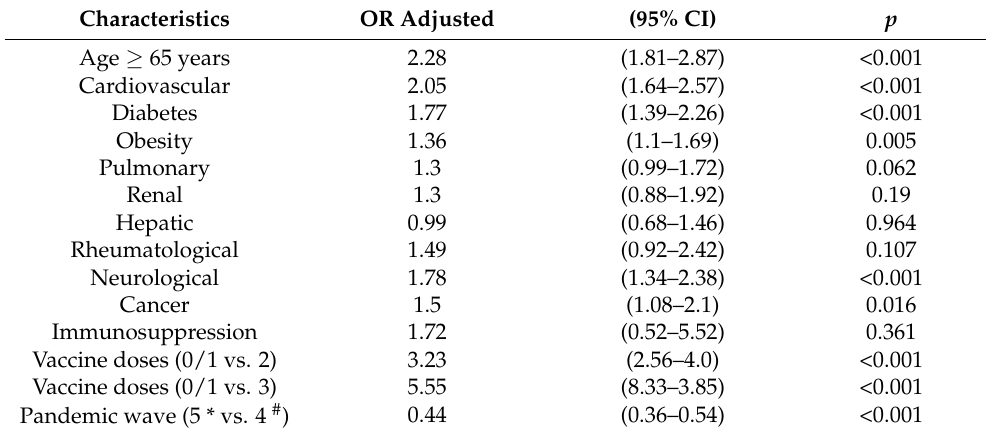
Table 3. Results of the multivariate logistic regression model predicting severe/critical COVID-19.